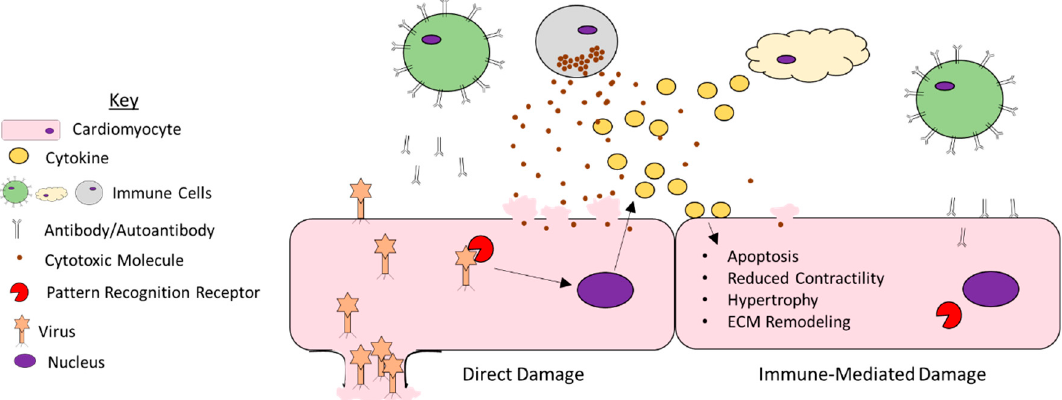
Figure 1. Mechanisms of viral myocarditis. A large number of viruses can infect cells of the heart and promote damage. They can promote direct damage by lysing host cells. Additionally, host cells are equipped with pattern recognition receptors that bind the virus and promote the expression of pro-inflammatory cytokines. While these cytokines can recruit immune cells that are necessary for viral clearance, they can also impair the function of uninfected myocytes by promoting apoptosis, reducing contractility, driving cardiomyocyte hypertrophy, and facilitating remodeling of the extracellular matrix. Furthermore, the immune cells recruited to the myocardium can damage uninfected myocytes through the release of cytotoxic molecules or through the production of autoantibodies.